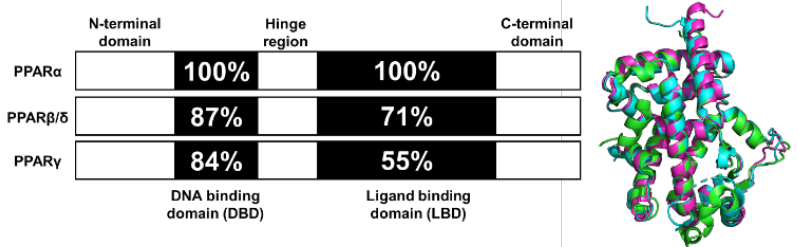
Figure 1. Functional domains and secondary structures of PPAR isoforms. Numbers denote residue identity in percent compared to PPAR α . Right is the overlap of the ligand-binding domain (LBD) for all PPAR isoforms. PPAR α -LBD (green, PDBID: 2P54), PPAR β / δ -LBD (cyan, PDBID: 3TKM), and PPAR γ -LBD (magenta, PDBID: 2VV0).